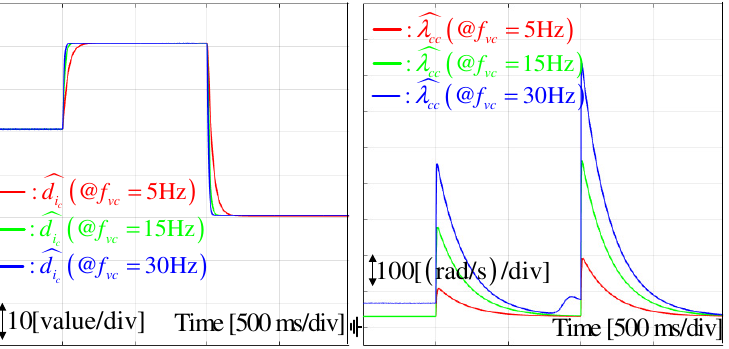
Figure 8. DOB and auto-tuner responses at f vc = 5, 15, and 30 Hz, and pulse reference tracking mode of R L = 20 Ω .